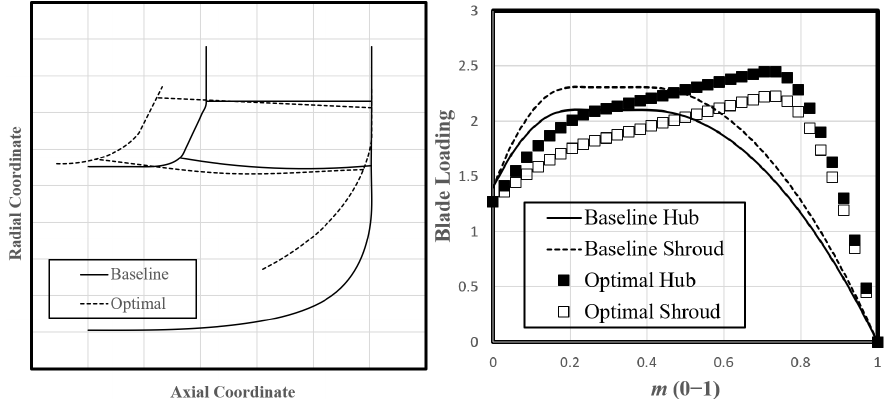
Figure 13. Comparison of meridional geometry and blade loading distribution for baseline and optimal design.